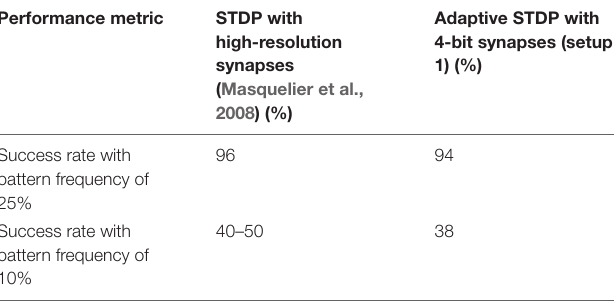
TABLE 2 | Comparison of the STDP and adaptive STDP learnings.